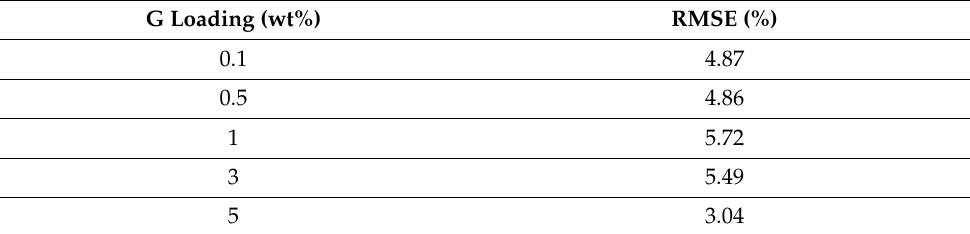
nanocomposites with different G